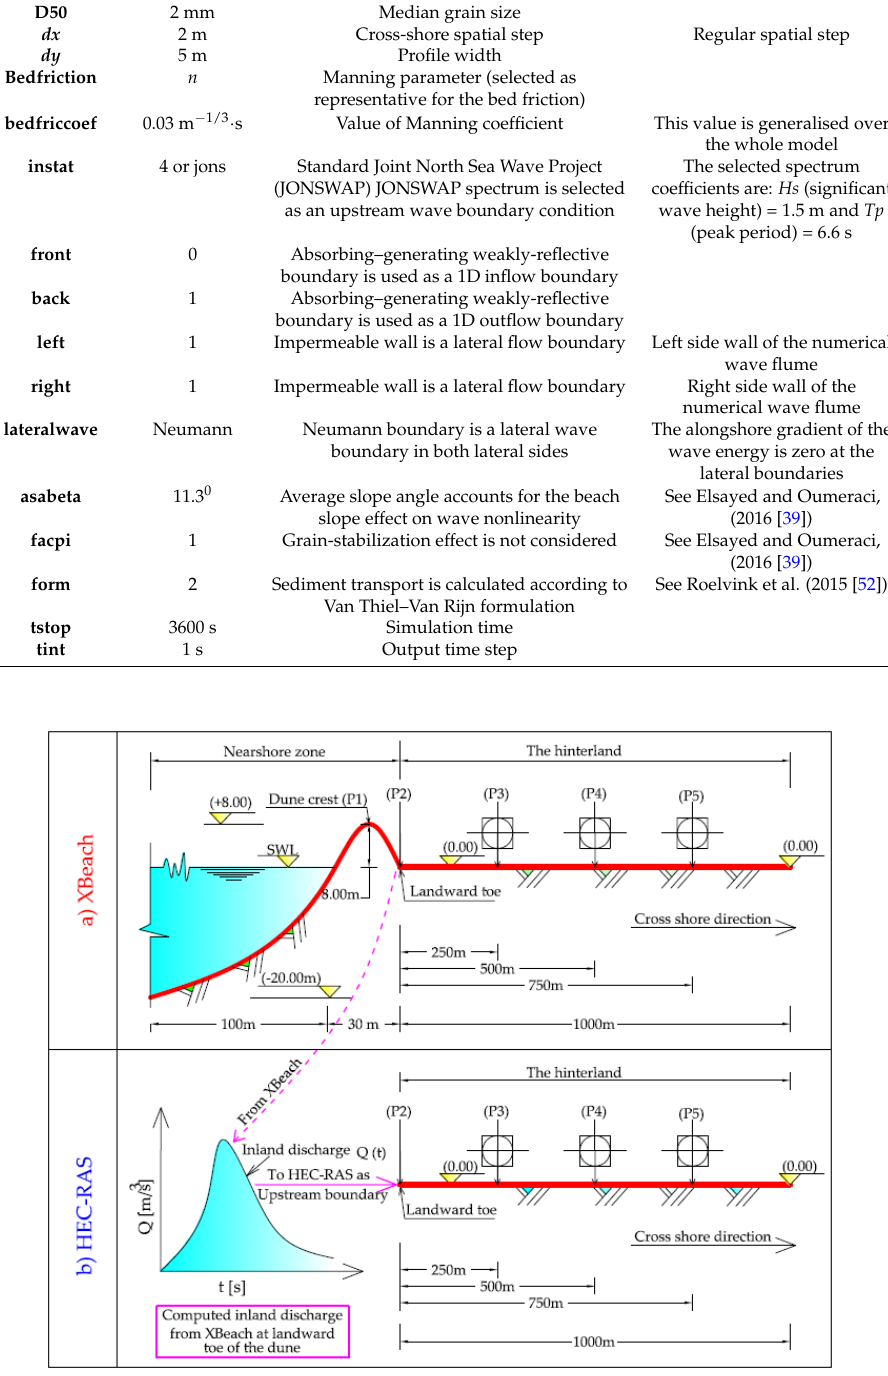
Figure 1. Test case 1: 1D synthetic cross-shore profile ( a ) 1D synthetic profile used in XBeach to simulate a 1D overwash event and the induced flood propagation in the hinterland and ( b ) the inland discharge Q(t) is computed from XBeach at point P2, where Q(t) serves as the inflow boundary condition for the HEC-RAS inundation model for the hinterland. The outcomes of the inundation from XBeach and HEC-RAS are compared at reference points P3, P4 and P5.